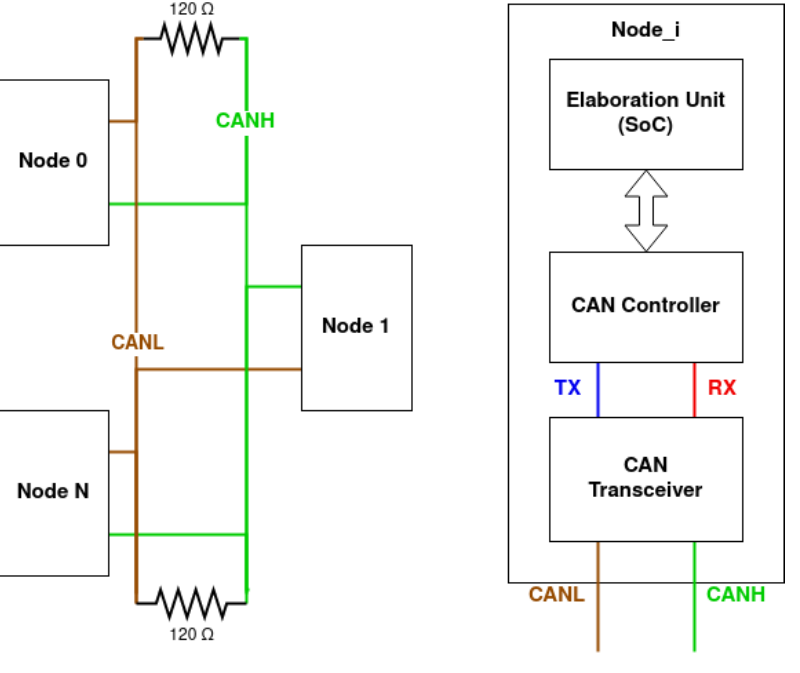
Figure 1. CAN bus